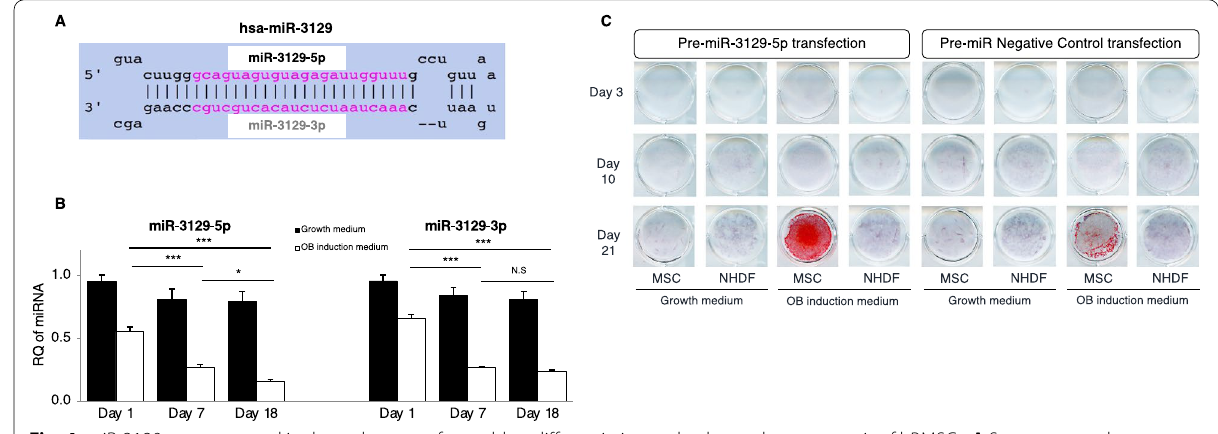
Fig. 4 miR‑3129 was expressed in the early stage of osteoblast differentiation and enhanced osteogenesis of hBMSCs. A Sequences and structure of human hsa‑miR‑3129, based on the miRBase database. B miR‑3129 expression was examined at the indicated time points during osteogenesis of MSCs. The levels of miRNA expression were quantified by qPCR. The amounts of miRNA transcripts were expressed relative to the amount of U6sn transcript. Data are expressed as mean SD from three independent experiments. C Calcification was examined in MSCs and NHDF cells treated ± with Pre‑miR‑3129‑5p and Pre‑miR‑NC by Alizarin Red S staining. Representative data are provided from three independent experiments (each n 3 in B and C ). * p <0.05, *** p <0.001 vs. day 1 by one‑way ANOVA. N.S, not significant; RQ, relative quantification; OB, osteoblast. NHDF, normal human dermal